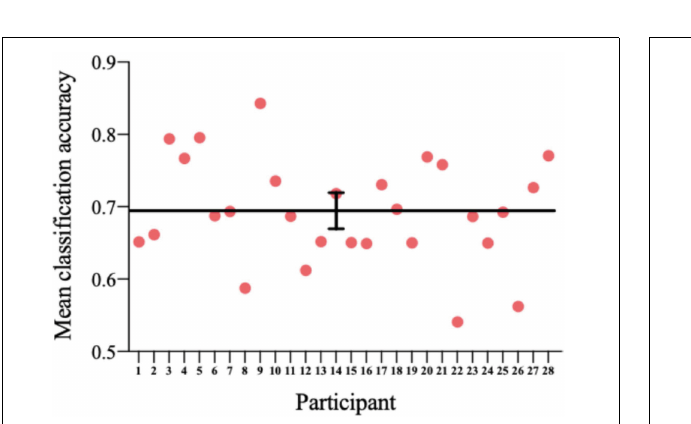
FIGURE 10 | The correlation between the mean decreased P300 amplitudes and decreased craving score ( r =